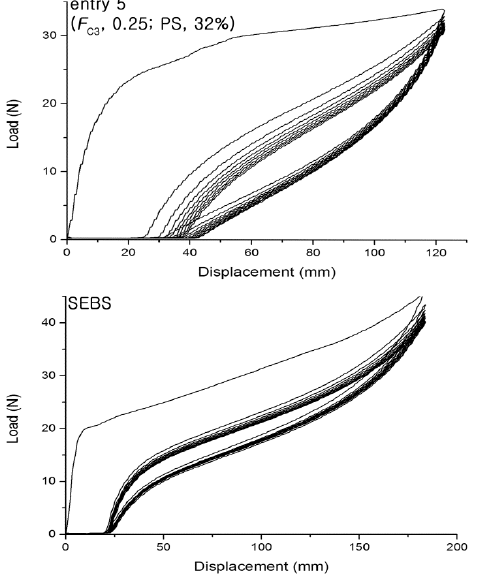
Figure 5. Plots of the cyclic tensile tests.